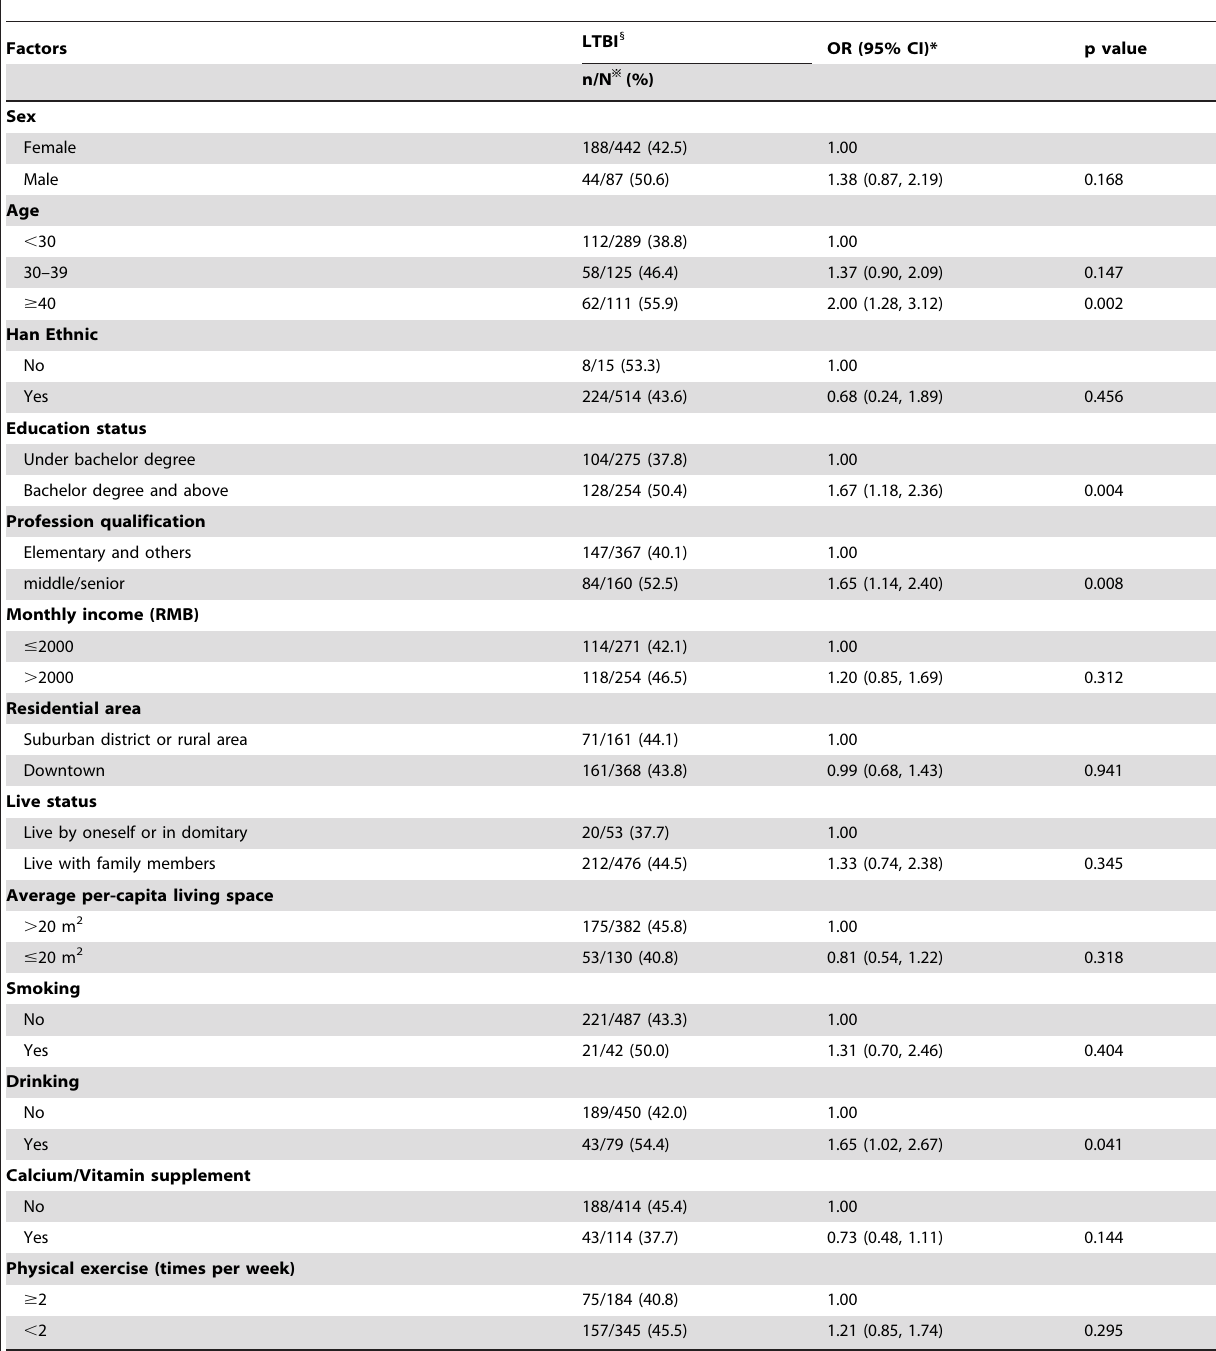
Table 1. Associations between demographical characteristics and habit with LTBI 1